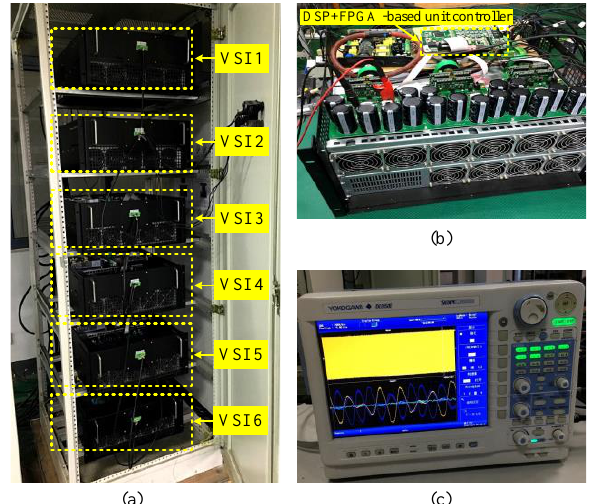
Figure 12. Experiment platform. ( a ) Multi-parallel grid-connected VSIs; ( b ) VSI unit; ( c ) ScopeCorder- DL850E.